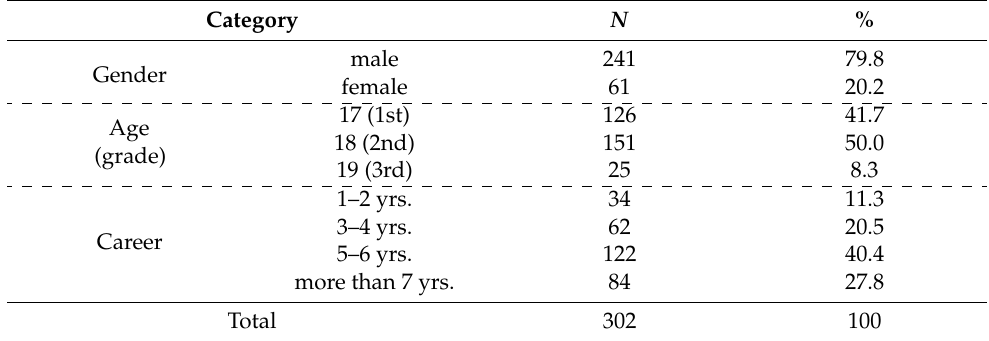
Table 1. Characteristics of